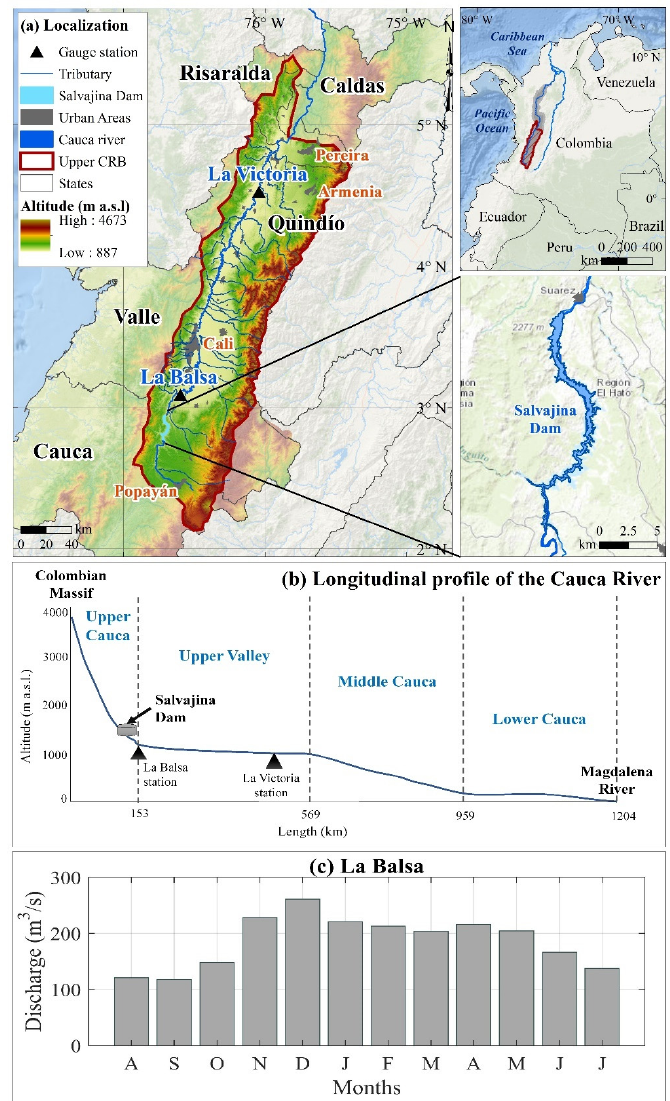
Figure 1. ( a ) Upper Cauca River Basin localization and study stations, ( b ) longitudinal profile of the Cauca River, and ( c ) annual discharge cycle at La Balsa station from 1949–2019.